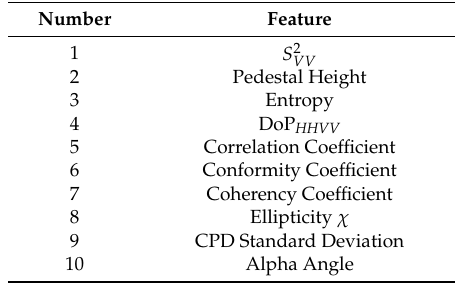
Table 3. Features that derived from quad-polarimetric SAR data.